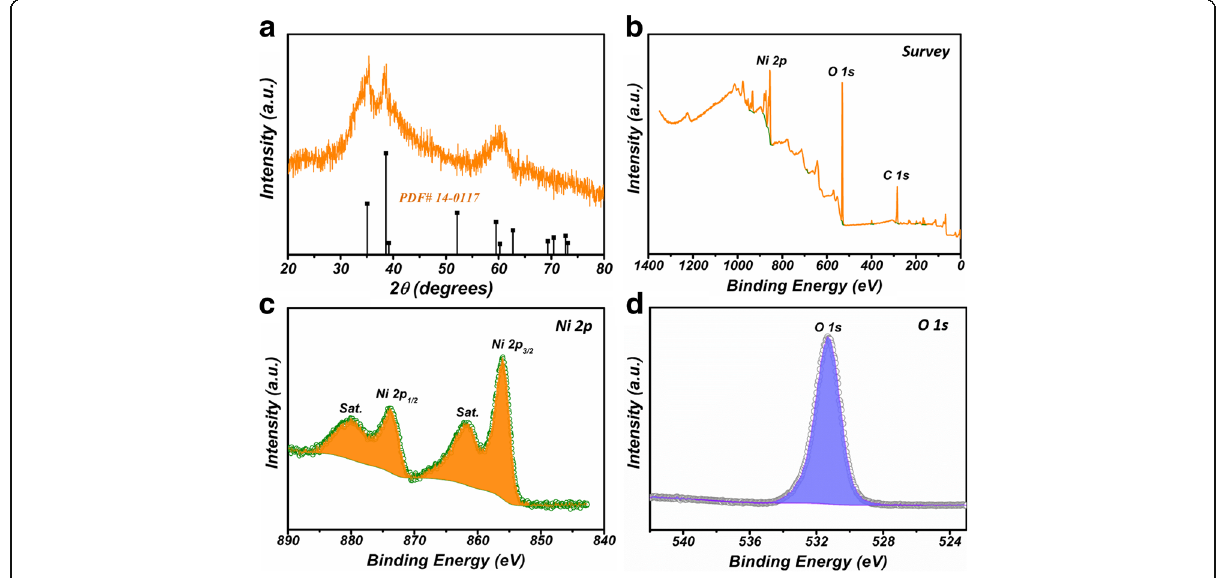
Fig. 1 a XRD pattern of the prepared Ni(OH) 2 NCs. b – d XPS spectra of the Ni(OH) 2 NCs. b Survey. c Ni 2p. d O